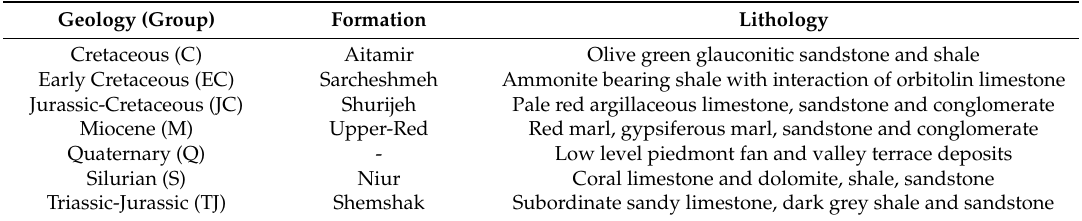
Figure 1. Karst spring location with hill-shaded map of the study area, Khorasan Shomali, Iran. Table 1. Geological formations in the study Table 1. Geological formations in the study area.